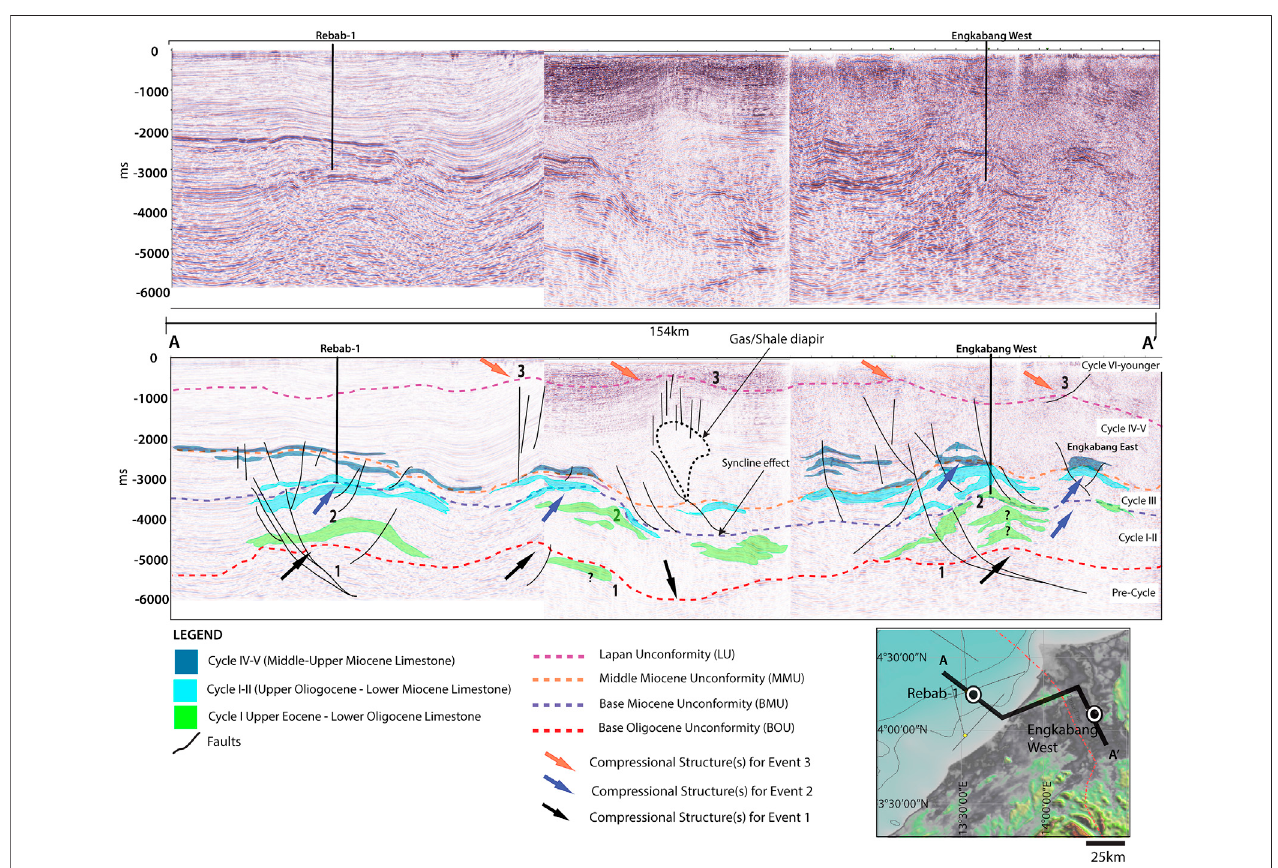
FIGURE 9 | Above) Correlation of seismic line in Figure 7 with a control line from offshore to onshore in Engkabang-Karap Anticline of Tinjar Province. Below) Interpreted section of the correlation of seismic line in Figure 7 . The annotation 1 – 3 is referring to Event 1 – 3 discuss in this paper. Upper Eocene to Middle Miocene limestone successions are observed at almost similar depth in the offshore and onshore. The interpretation of Engkabang West anticline is guided by Jong et al. (2016). Inset map is showing the orientation of A-A ′ line from offshore to onshore.